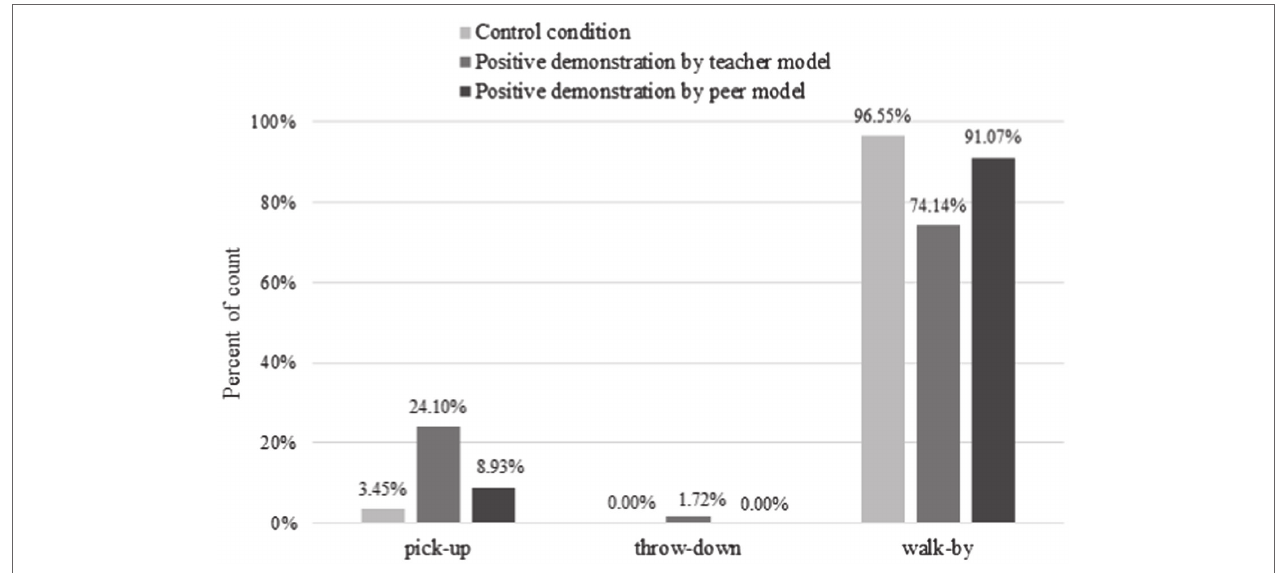
FIGURE 3 | Percentage of subjects engaging the three target behaviours in the Control, PDTM, and PDPM conditions.